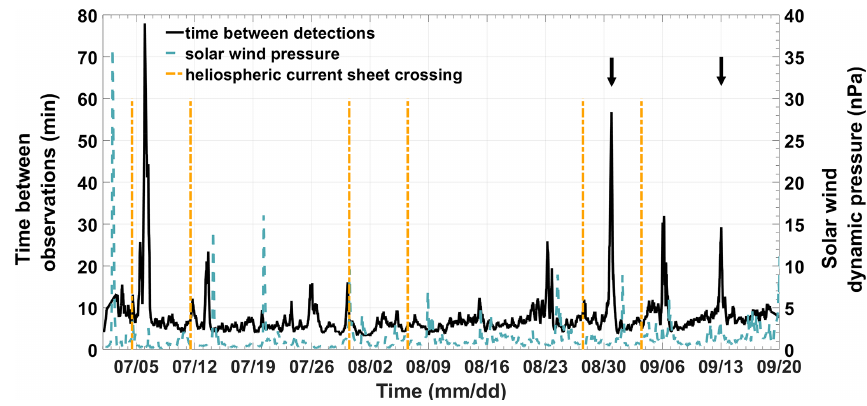
Figure 4. Averaged time between detections (solid line) and the solar wind dynamic pressure (dashed line) from 1 July until 20 Septem- ber 2015. The solar wind pressure was extrapolated from near Earth to 67P/CG using the model by Tao et al. (2005). The vertical lines denote the dates of HCS crossings. Occasional sharp increases in the time between detections are visible. Examples of the magnetic field magnitude for the occurrences marked by the arrows are shown in Fig. 5.